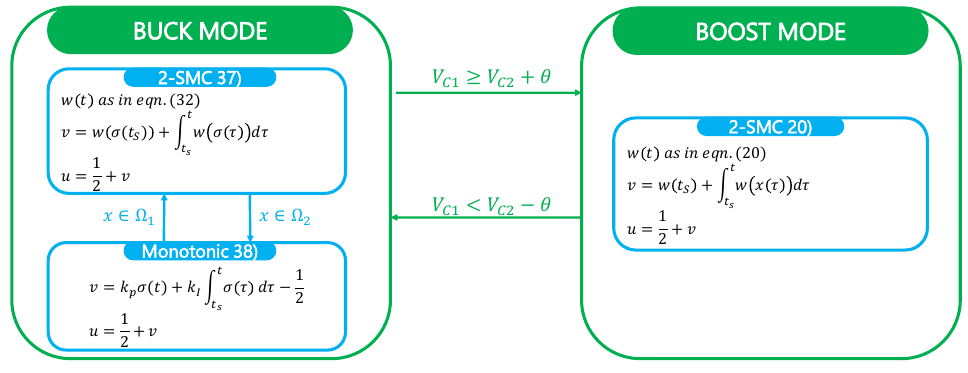
Figure 3. Supervisory